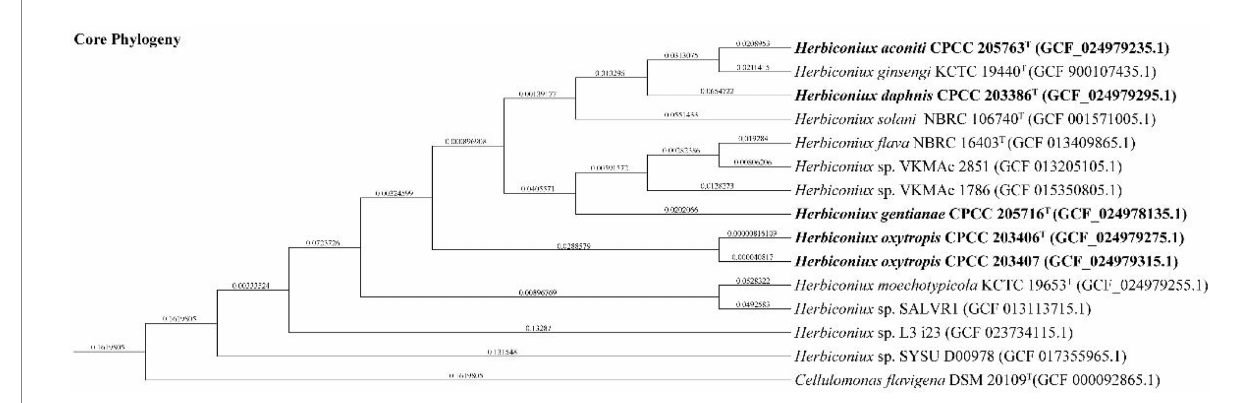
FIGURE 2 Phylogenetic tree constructed by BPGA showing the relationship of the newly proposed species with other species of the genus Herbiconiux based on concatenated core